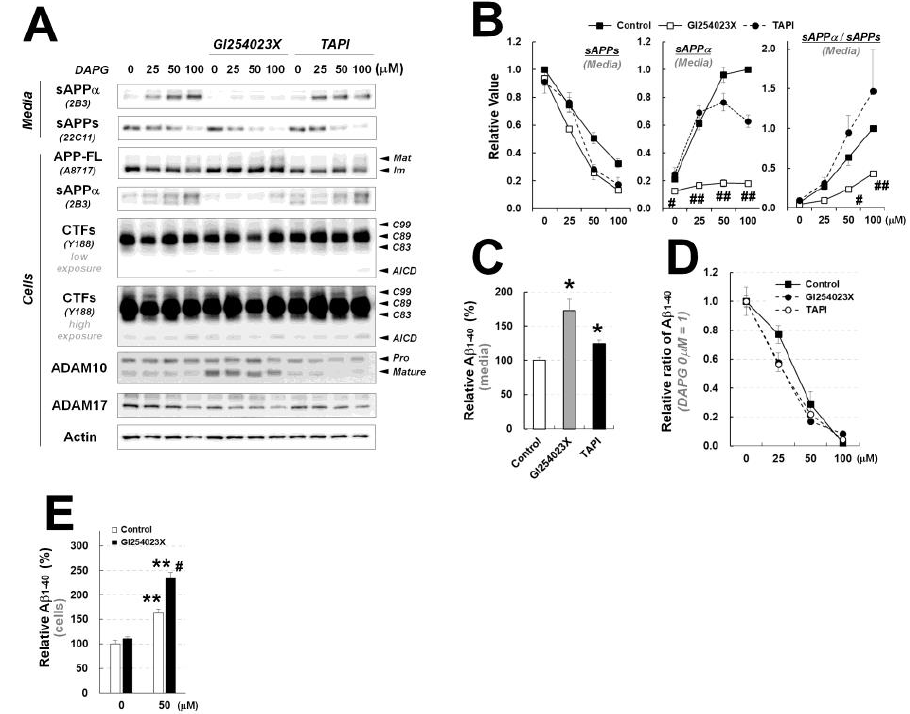
Figure 7. Examination of the effects of ADAM10 and ADAM17 inhibitors on DAPG-mediated decrease in A β levels and changes in APP processing in 293sw cells. ( A ) Immunoblot analysis of APP processing and expression of ADAM10 and ADAM17 in 293sw cells co-treated with 0–100 µ M DAPG and 10 µ M GI243023X (an ADAM10 inhibitor) or 10 µ M TAPI (an ADAM17 inhibitor) for 8 h. ( B ) Densitometry analyses of the immunoblots from ( A ) for sAPP α and sAPPs levels in the culture medium and the ratio of sAPP α to sAPPs levels. Values are presented as means ± SEMs (n = 3). Statistical significances of the differences between DAPG-treated group and both DAPG- and GI254023X-treated group ( # p < 0.05, ## p < 0.01) were determined using one-way ANOVA followed by Tukey’s test. ( C ) ELISA analysis of A β 1–40 levels in the medium of 293sw cells treated with GI254023X or TAPI for 8 h. Values are presented as means ± SEMs (n = 3). Statistical significances of the differences between treated groups and untreated controls were determined using Student’s t -test (* p < 0.05). ( D ) Relative ratio of A β 1–40 in the medium of 293sw cells compared with DAPG-untreated group determined by ELISA analysis after treatment with 0–100 µ M DAPG with or without GI254023X and TAPI for 8 h. ( E ) ELISA analysis of intracellular A β 1–40 levels after treatment of 293sw cells with 50 µ M DAPG in presence or absence of GI254023X for 8 h. Values are presented as means ± SEMs (n = 3). Statistical significances of the differences between DAPG-untreated group and DAPG-treated group (** p < 0.01) or between DAPG-treated group and both DAPG- and GI254023X-treated group ( # p < 0.05) were determined using one-way ANOVA followed by Tukey’s test.